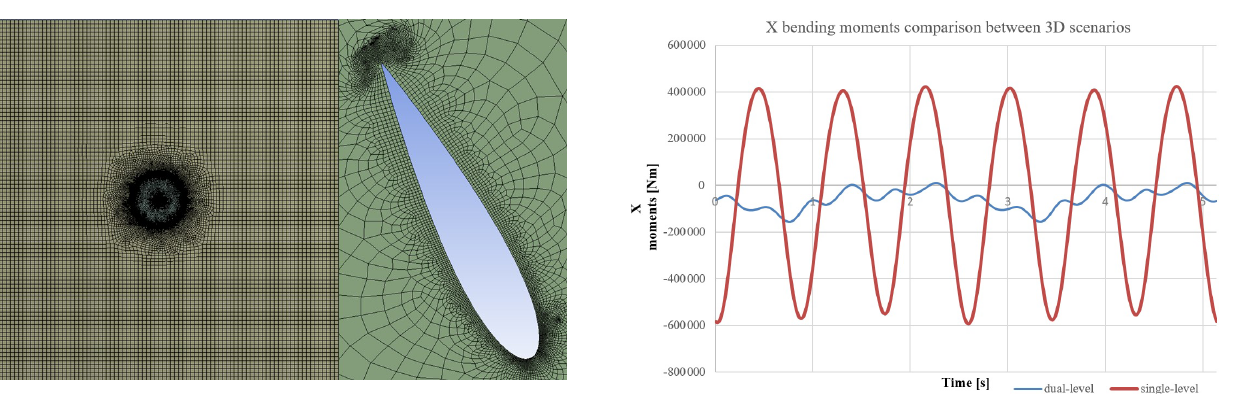
Figure 11. X -bending moments comparison between 3D